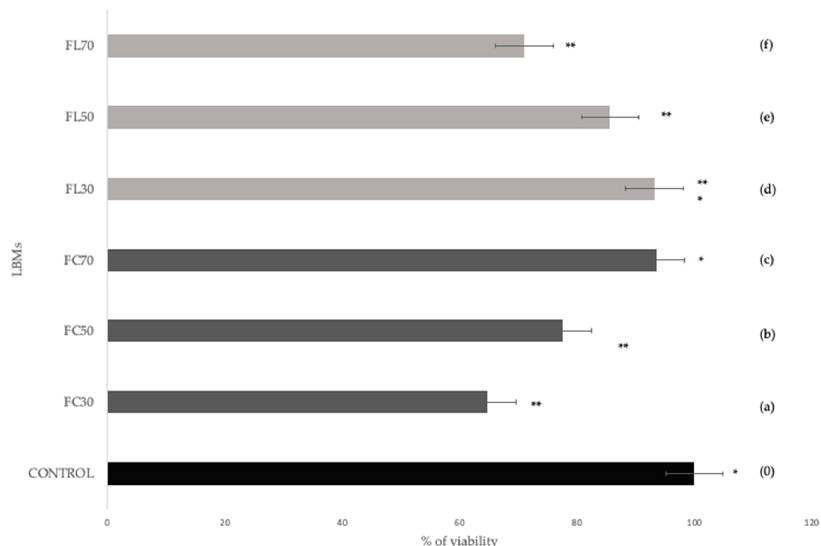
Figure 2. Average cytotoxic evaluation of LBMs in human fibroblast culture medium during the three cytotoxicity evaluations. Associated with the micrographs of Figure 3, (*, **) values with different sets are significantly different at p -value < 0.05 in the bilateral equality test for column means. The tests assumed equal variances.